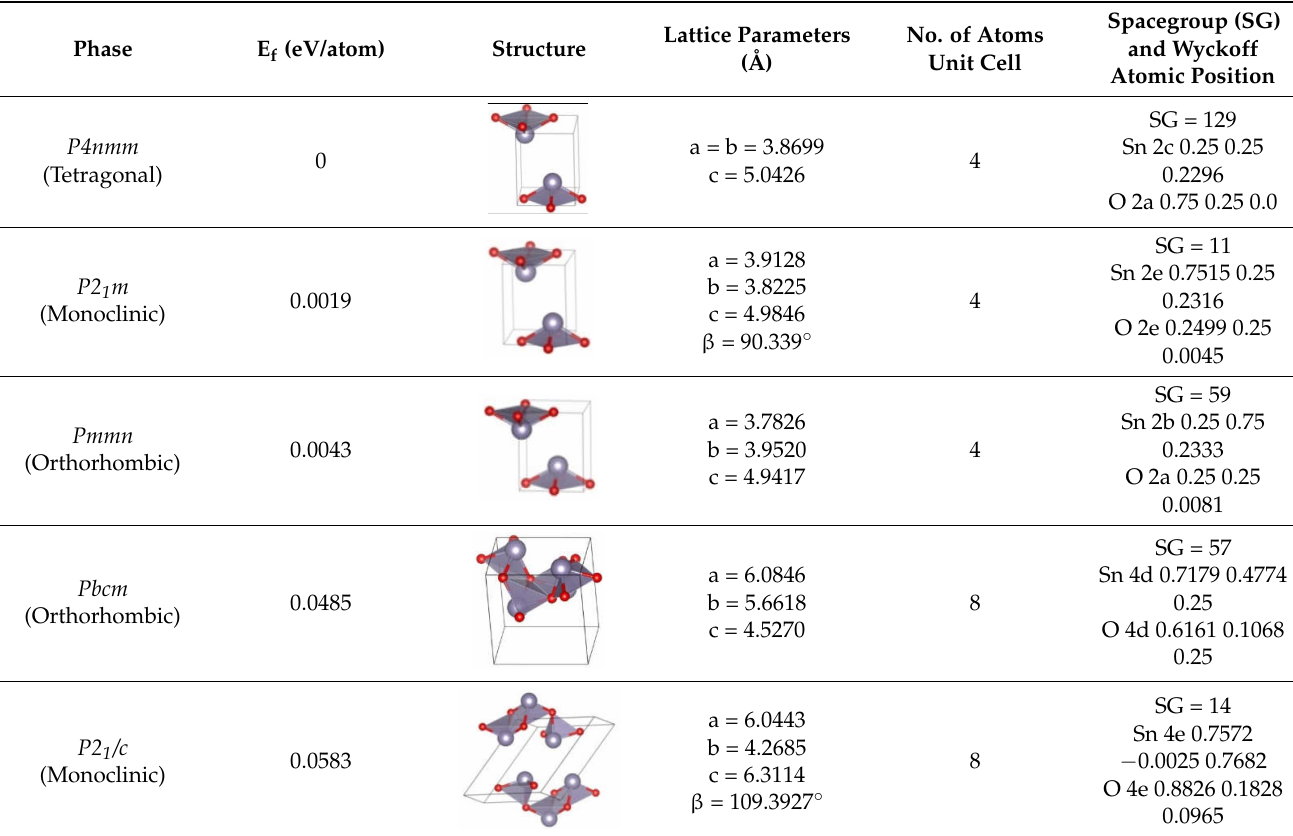
Table 1. Low enthalpy SnO phases predicted by the GA at P = 0 GPa and their structural parameters (Sn: light blue and O: